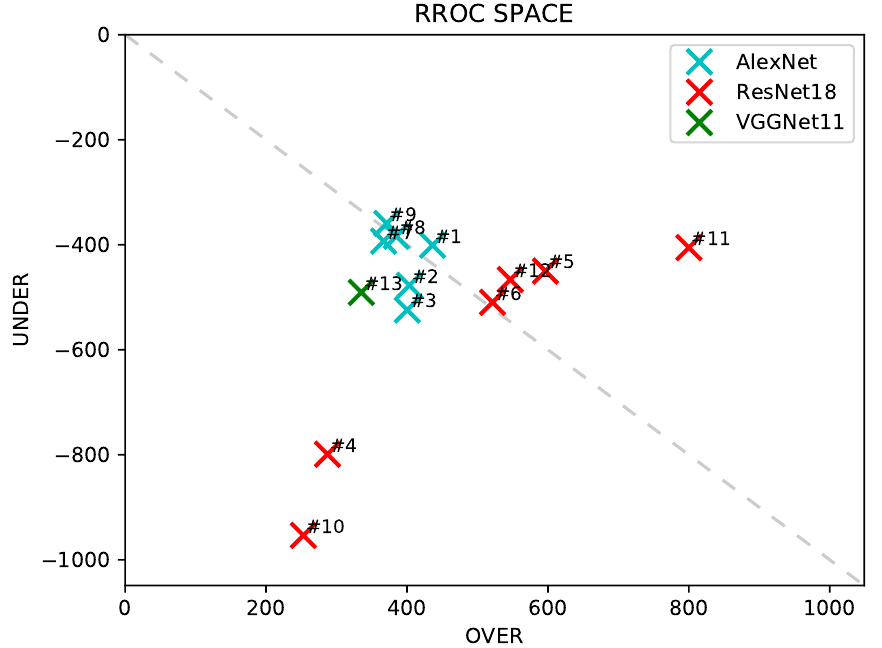
Figure 6. ROC (Receiver Operating Characteristic) for regression. Points closer to (0,0) mean better